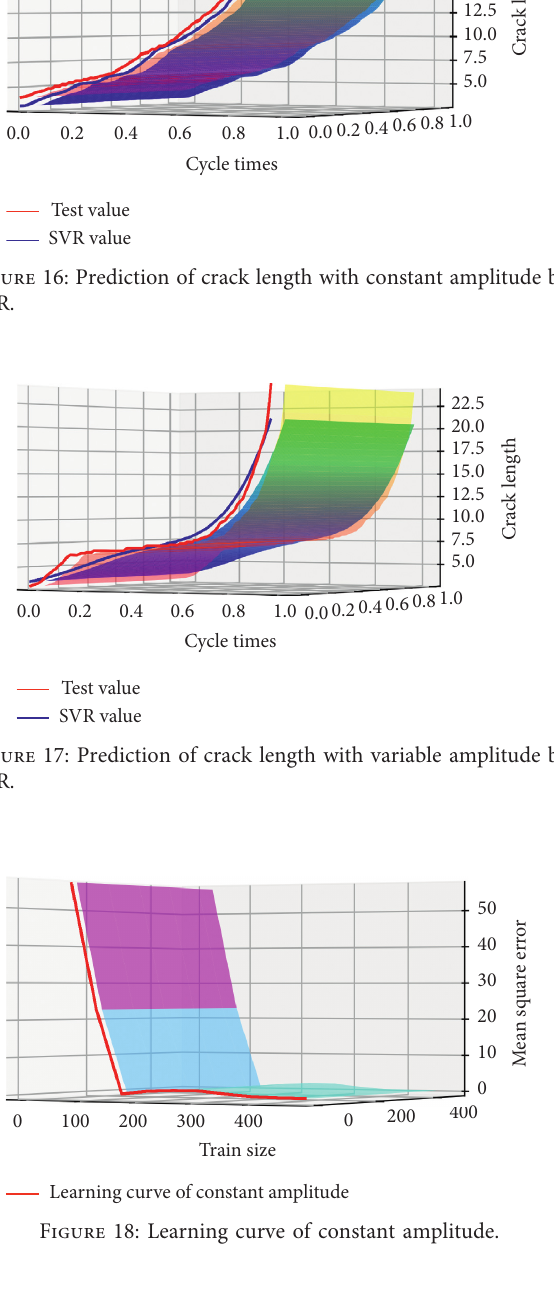
Figure 18: Learning curve of constant amplitude.